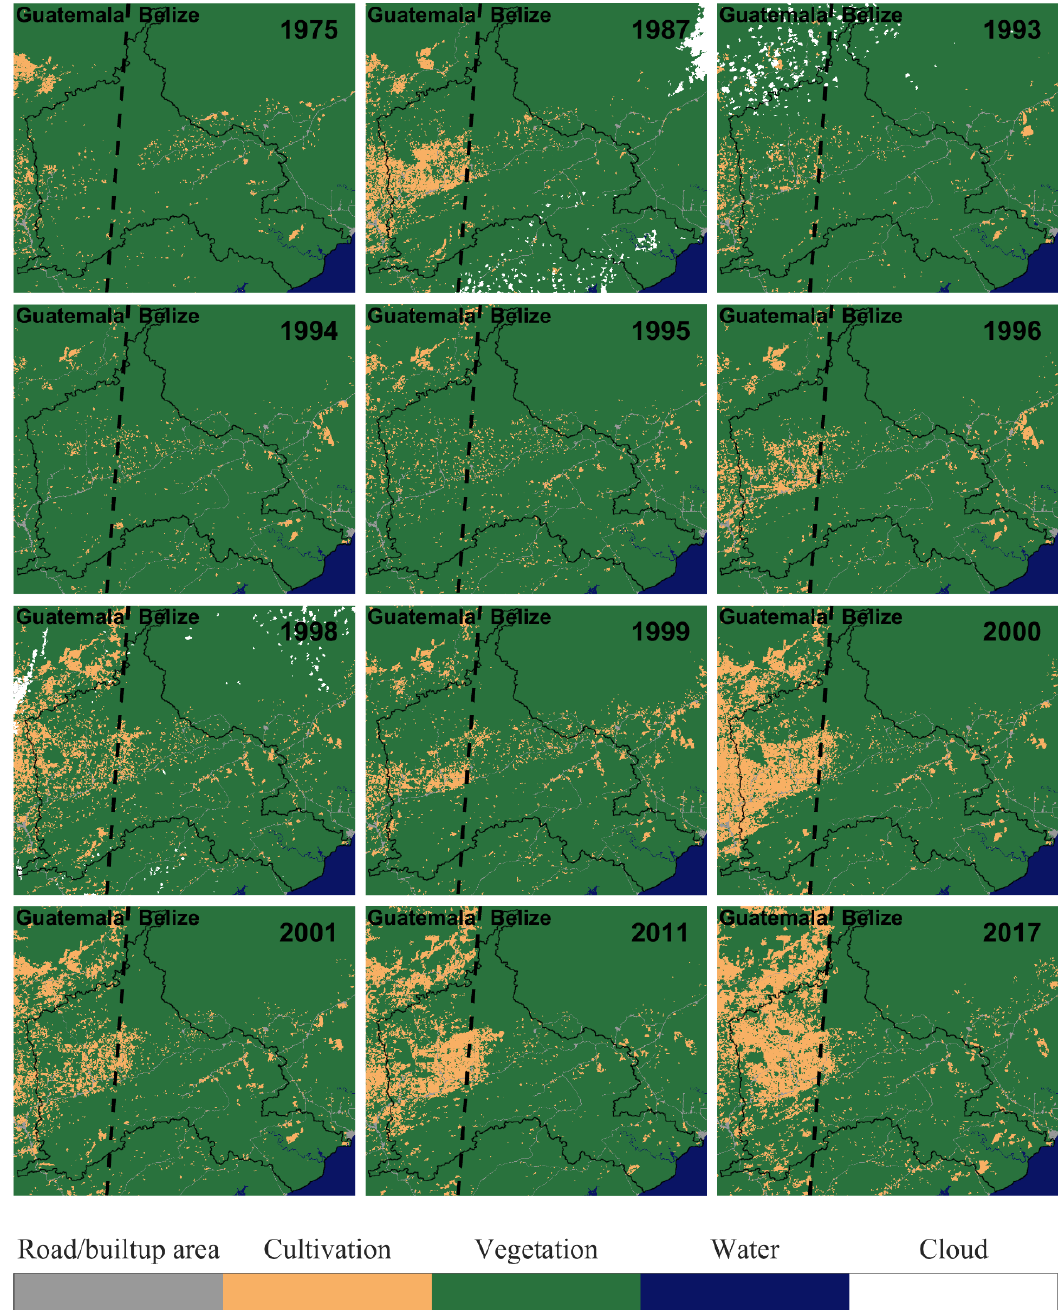
Figure 2. Time series of land use and cover change (LUCC) classification results showing an increase in intensive cultivation starting in Guatemala and spreading into the Belizean portion of the Moho River watershed.